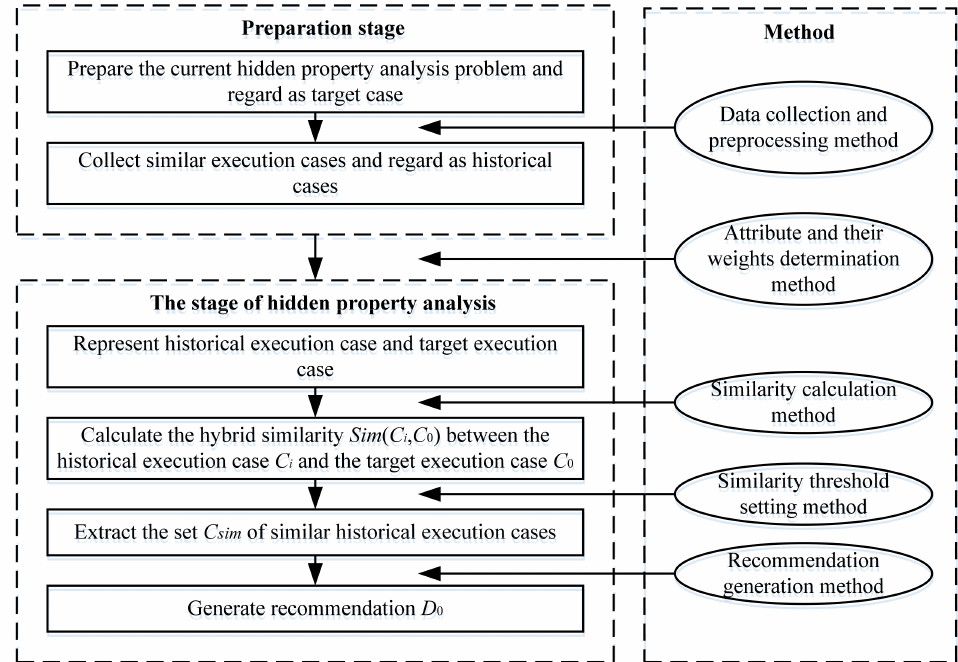
Figure 2. The framework of CBR for hidden property analysis of a judgment